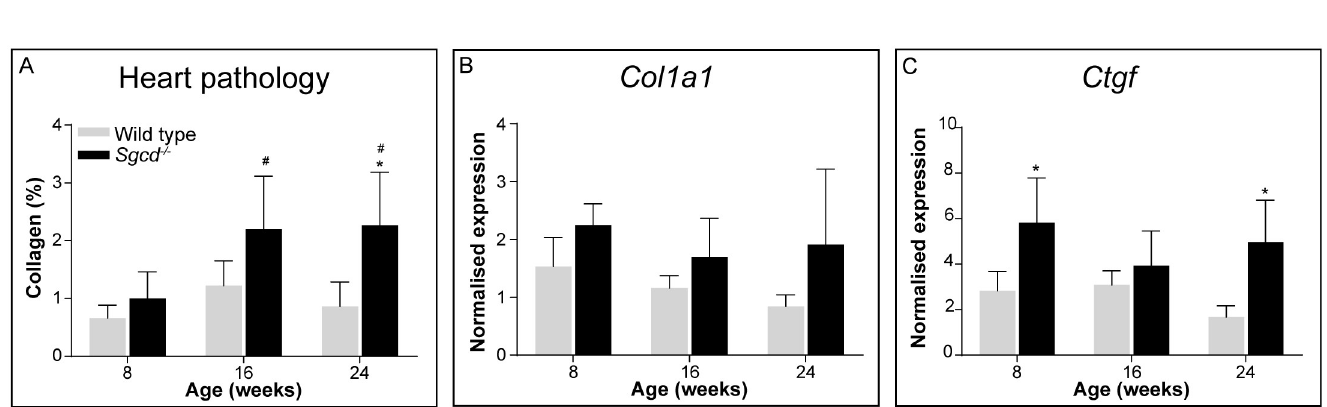
Fig 7. Heart pathology in Sgcd -/- males. (A) Collagen type I staining of fibrotic area. Gene expression of Col1a1 (B) and Ctgf (C). N = 6 male mice per group. � p < 0.05 vs age-matched wild type mice, # p < 0.05 over time (same genotype).